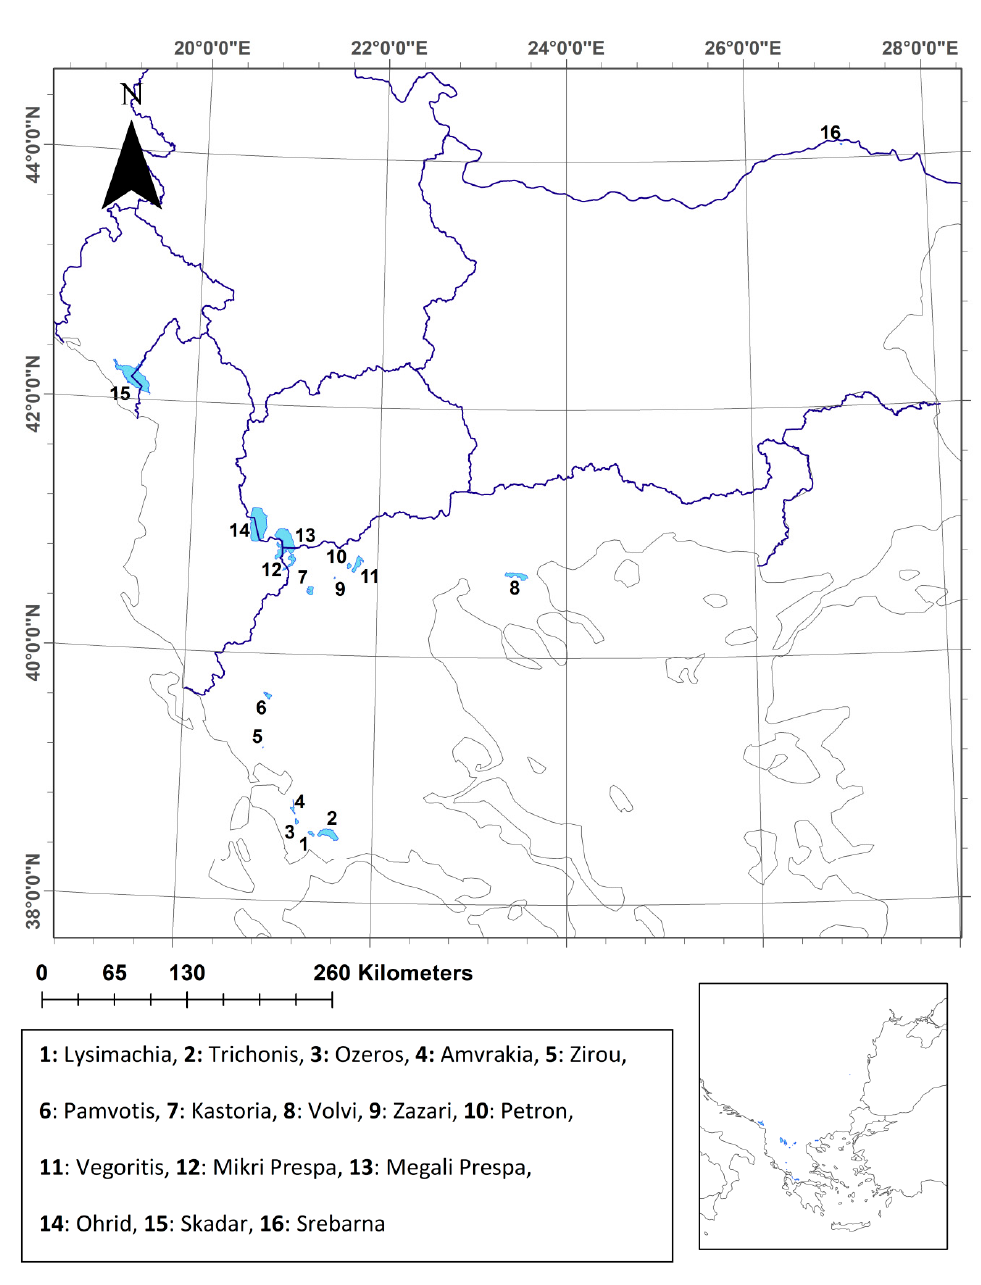
Figure 1. Location of the sixteen studied lakes in the Southern Balkan Peninsula.